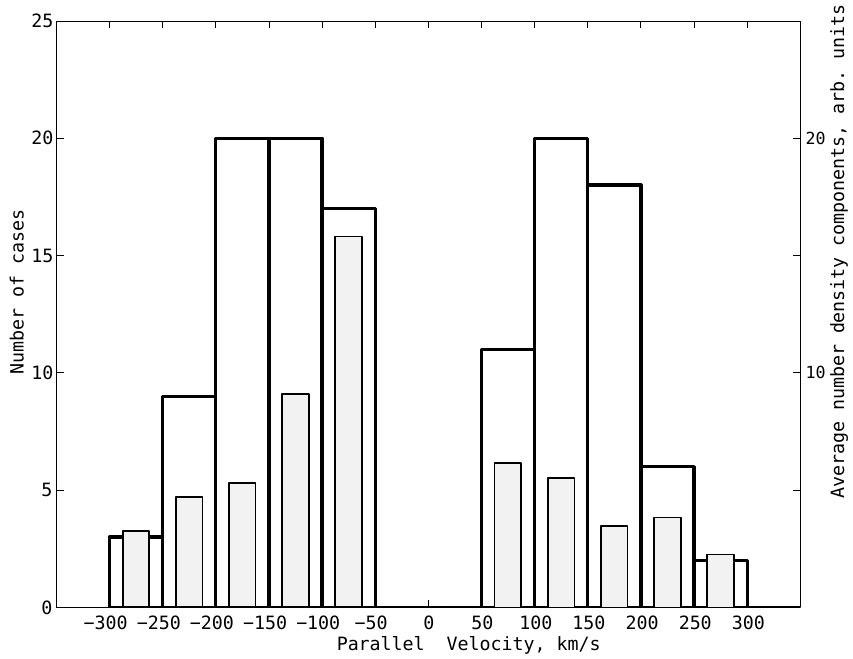
Fig. 12. Statistical distribution of velocities and number densities of counter-streaming components are shown as observed in the LLBL on 15 February 1996. LLBL intervals 3 and 5 from Fig. 2 and three LLBL transients from Fig. 4 are included. Empty columns are convected Maxwellian velocity distributions, gray columns are for average number density of components within a given velocity